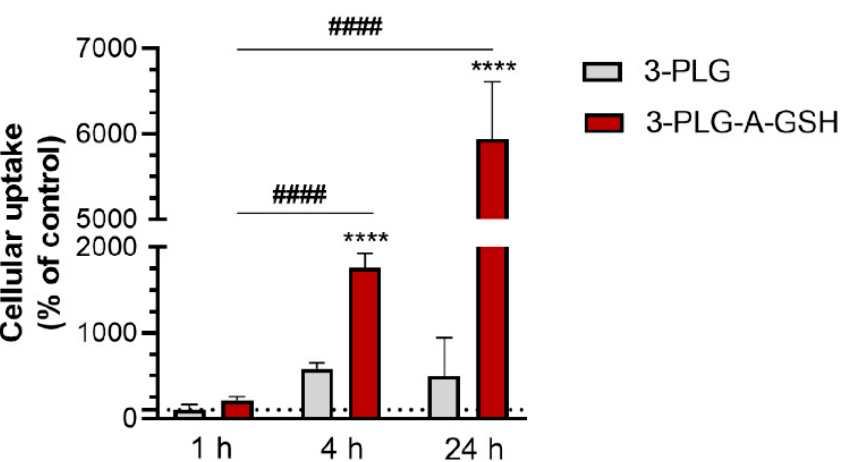
Figure 5. Cellular uptake of non-targeted (3-PLG) and alanine–glutathione-targeted (3-PLG-A-GSH) polypeptide nanocarriers in cultured human brain endothelial cells after 1, 4 and 24 h of incubation (100 µ g/mL; 37 ◦ C). Values presented are means ± SD and are given as a percentage of the 3-PLG group’s 1 h time point. Statistical analysis: two-way ANOVA; **** p < 0.0001 compared to the 3-PLG group at each time point; #### p < 0.0001 compared to the 3-PLG-A-GSH group at the 1 h time point; n = 6. In concordance with the results of the uptake experiment, the high-level internaliza- tion of 3-PLG-A-GSH was also verified by confocal microscopy. After 24 h incubation with 3-PLG, a low R6G signal could be detected in the cytoplasm of hBECs (Figure 6a), com- pared to the intensive R6G fluorescence of the dual-targeted PLG-A-GSH (Figure 6b). The results of image analysis also verify that the cellular entry of dual-targeted nanocarriers is significantly higher (1.7-times elevation) than the uptake of non-targeted 3-PLG (Figure 6c). To reveal the mechanisms of cellular uptake, we used low temperature (4 ◦ C) and randomly methylated β -cyclodextrin to block endocytosis (Figure 7). In these experiments, a 4 h timepoint and a lower concentration of nanocarriers (50 µ g/mL) were used. Randomly methylated β -cyclodextrin (5 mM, 1 h pretreatment), which inhibits endocytosis by the selective extraction of cholesterol from the plasma membrane [54], significantly decreased the cellular internalization of 3-PLG-A-GSH compared to the group that did not receive inhibitor (Figure 7c). No effect was seen in the case of non-targeted nanocarriers (Figure 7b). At 4 ◦ C, a low-level internalization of 3-PLG and 3-PLG-A-GSH was measured (Figure